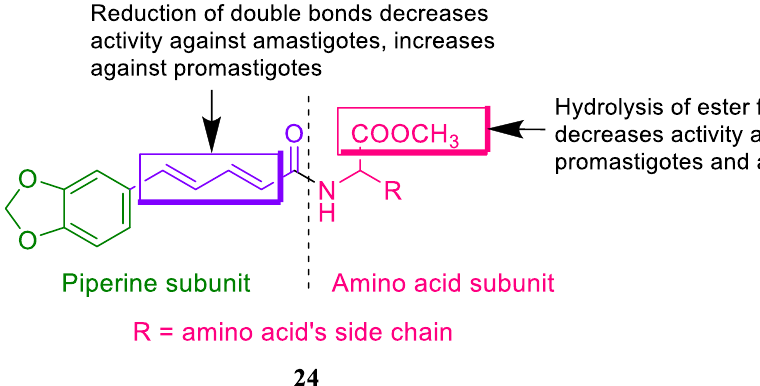
Figure 31. Amino acids conjugated to piperoyl derivatives.